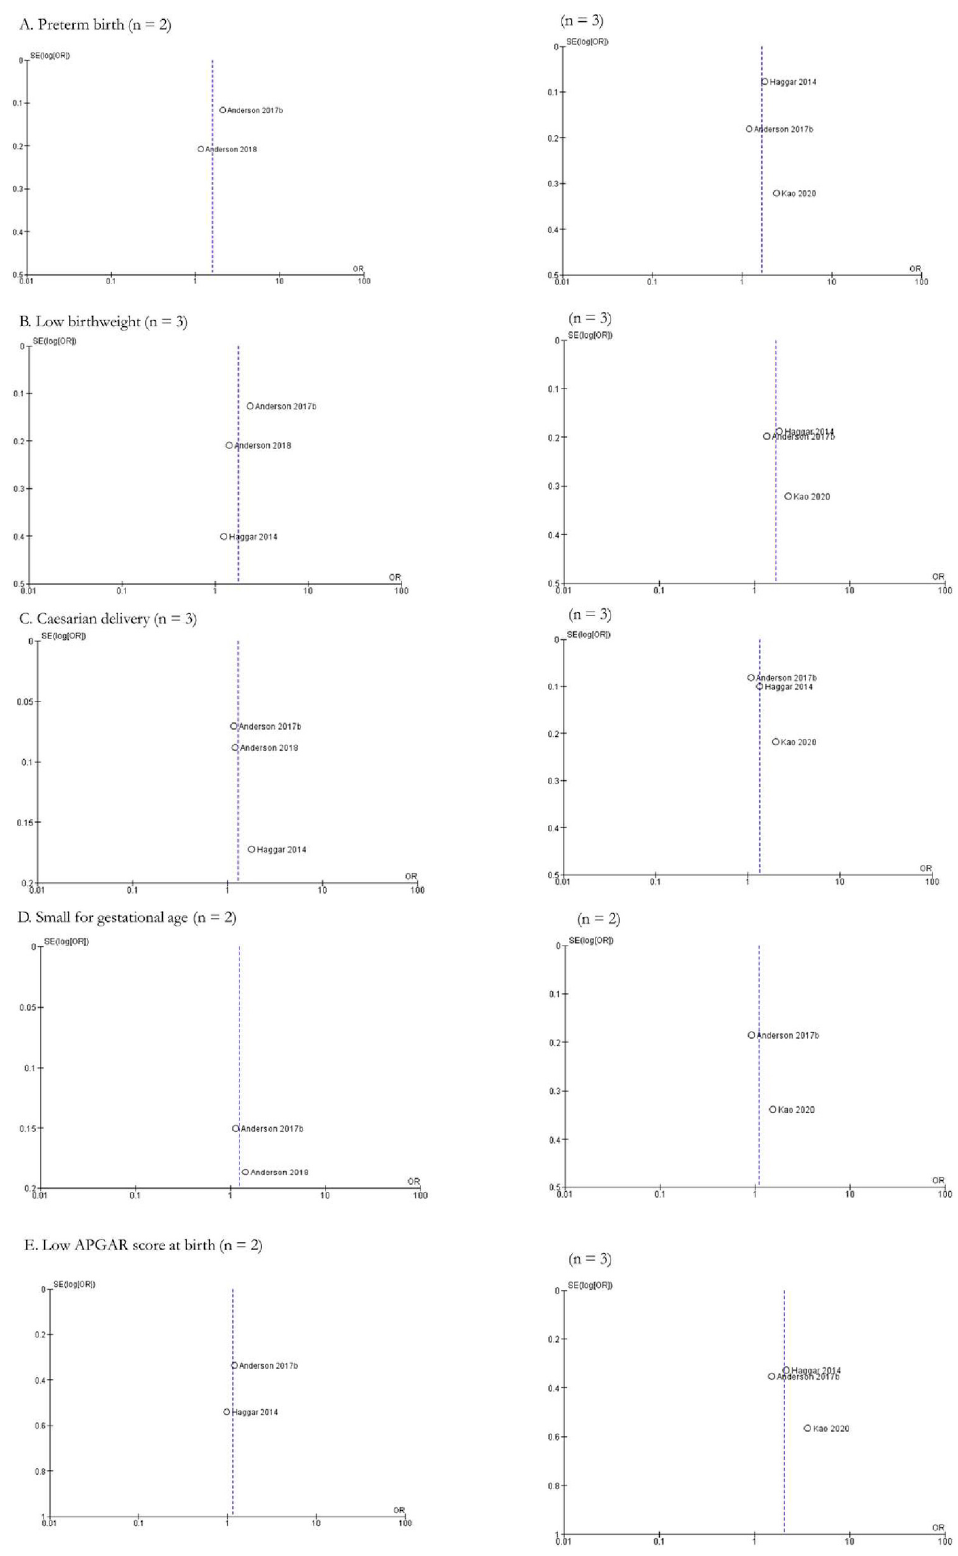
Figure 11. Funnel plots of meta-analyses of cancer treatment (chemotherapy or radiation compared to controls) and reproductive health outcomes (n = 5). ( A ). chemotherapy: [39,42]; radiation: [27,36,42], ( B ). chemotherapy: [36,39,42]; radiation: [27,36,42], ( C ). chemotherapy: [36,39,42]; radiation: [27,36,42], ( D ). chemotherapy: [39,42]; radiation: [27,42], ( E ). chemotherapy: [36,42]; radiation: [27,36,42].